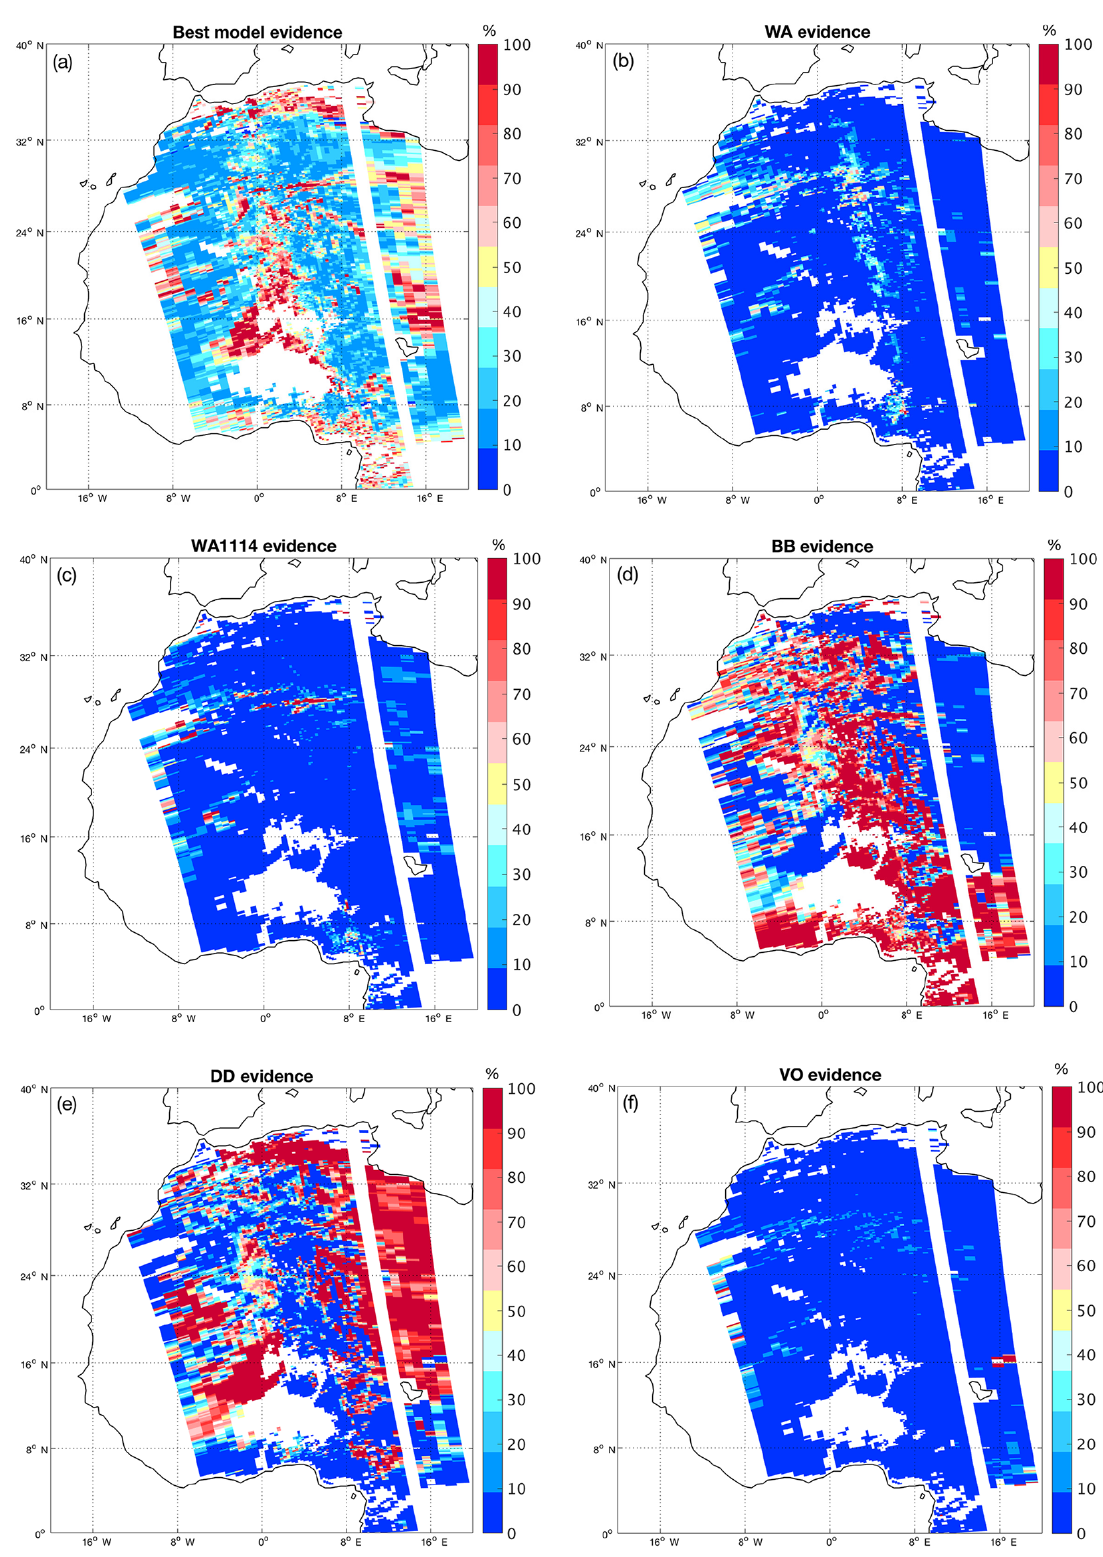
Figure 11. Same as Fig. 4 but showing the relative evidence distribution (%) of the selected best models in the Africa case on 26 March